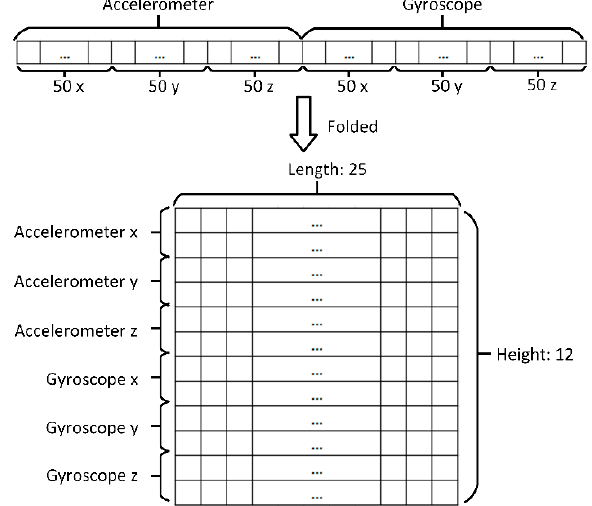
Figure 8. Data rearrangement: a one-dimensional sequence ( 1 × 300 ) is folded into a two-dimen- sional vector ( 12 × 25 ).